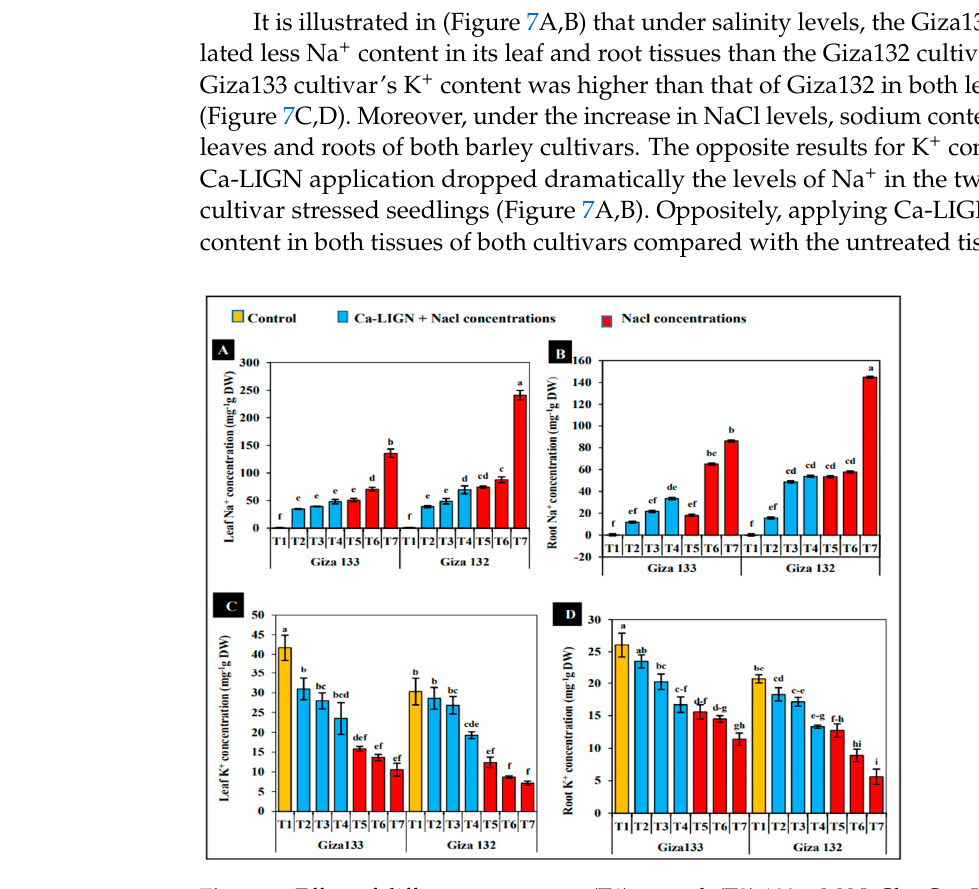
Figure 7. Effect of different treatments: (T1) control, (T2) 100 mM NaCl + Ca − LIGNO, (T3) 200 mM NaCl + Ca − LIGNO, (T4) 300 mM NaCl + Ca − LIGNO, (T5) 100 mM NaCl, (T6) 200 mM NaCl, and (T7) 300 mM NaCl on the average Na + concentrations in leaf ( A ) and root ( B ) and K + concentrations in leaf ( C ) and root ( D ) of the two barley cultivars, Giza133 and Giza132, during two seasons, 2019/2020 and